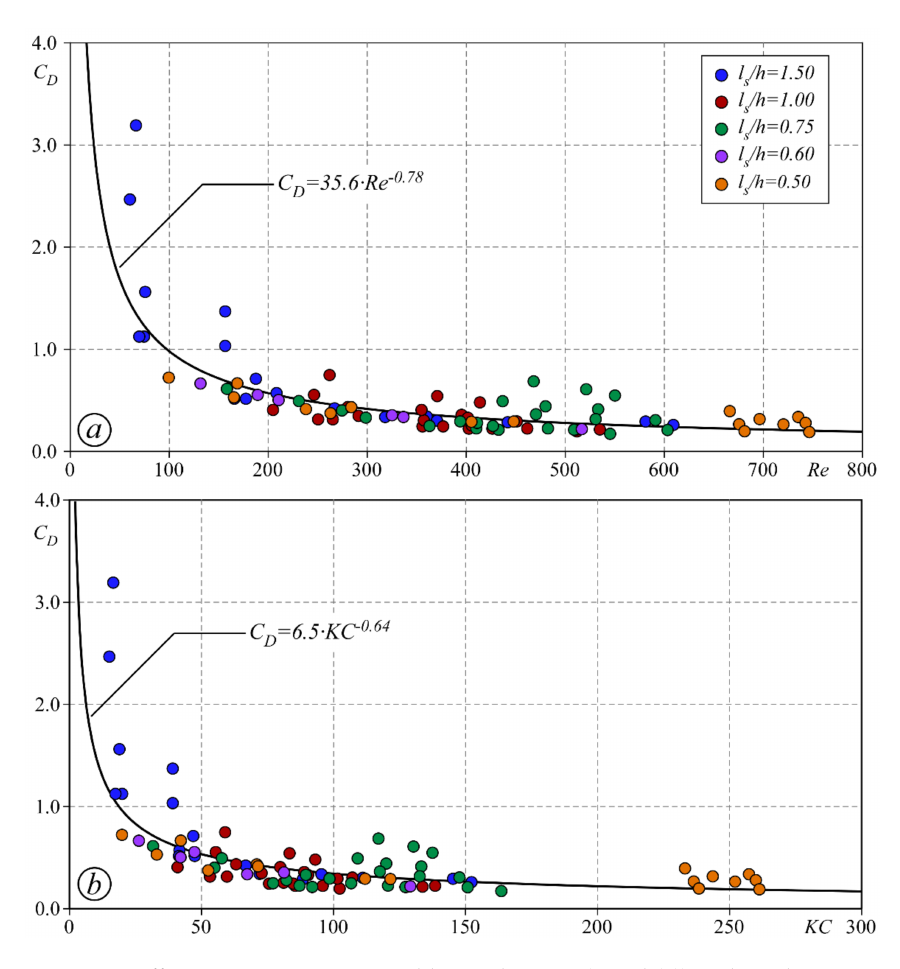
Figure 7. Drag coefficient, C D , versus Reynolds number, Re , (panel ( a )) and Keulegan–Carpenter number, KC , (panel ( b )). The solid black line represents the regression of experimental data (circles) according to Equation